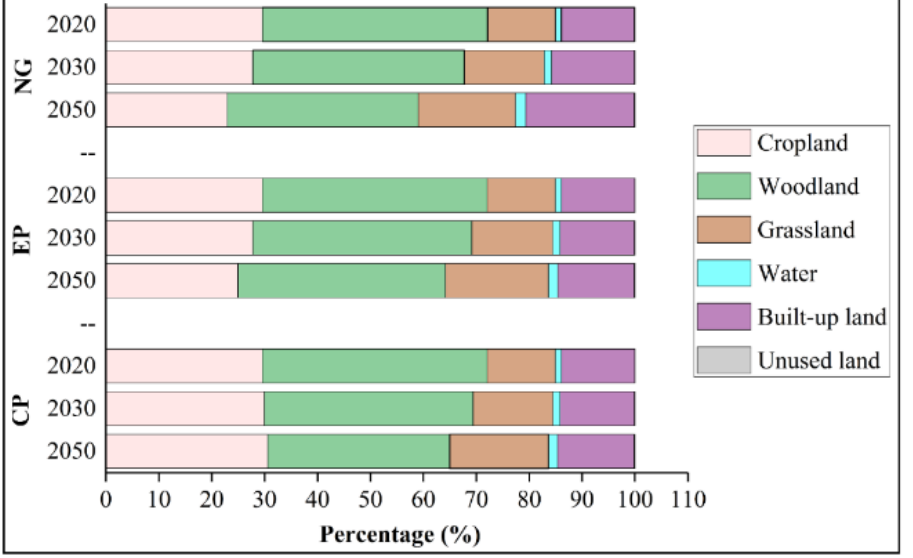
Figure 4. The area changes of future land-use types under the scenarios of natural growth scenario (NG), cropland protection scenario (CP), and ecological protection scenario (EP) in 2030 and 2050, compared to 2020.